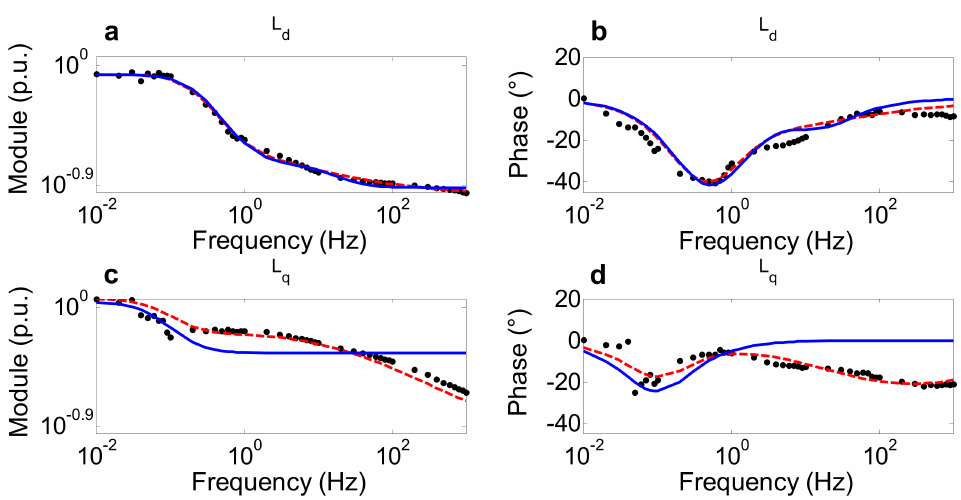
Figure 3. Bode diagrams of the 125 kVA synchronous generator inductances L d and L q (black dots—measurements, blue solid line—integer order model, red dashed line—non-integer order model). ( a ) module of operational inductance L d , ( b ) phase of operational inductance L d , ( c ) module of operational inductance L q , ( d ) phase of operational inductance L q